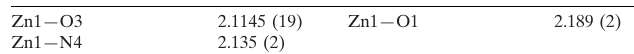
Selected bond lengths (A˚ ).